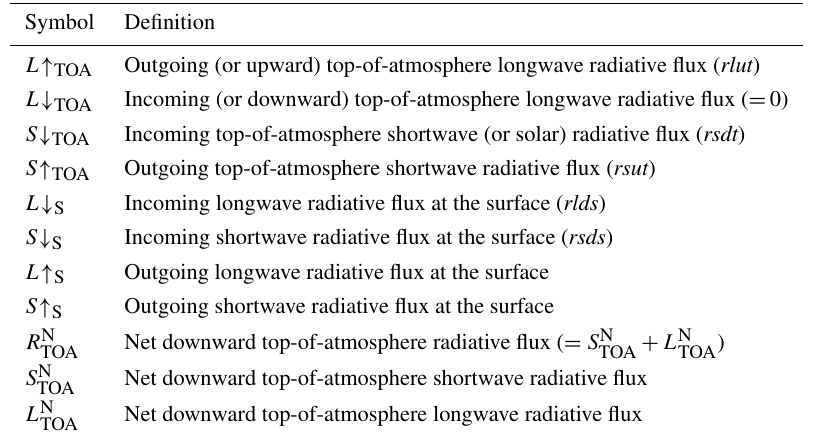
Table 2. List of radiative flux symbols for all-sky conditions.